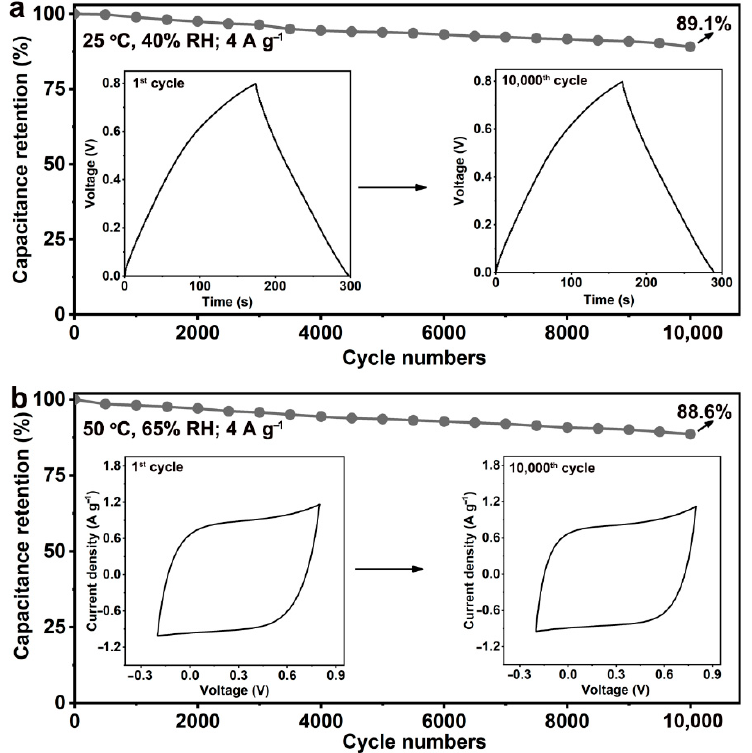
Figure 4. Cycle stability of BP/C SC. ( a ) Stability of BP/C SC at 25 ◦ C and 40% RH during 10,000 cycles; insert, 1st and 10,000th cycle curves. ( b ) Stability of BP/C SC at 50 ◦ C and 65% RH for 10,000 cycles; insert, 1st and 10,000th cycle curves. The current density for both galvanostatic charge–discharge cycles is 4 A g − 1 .